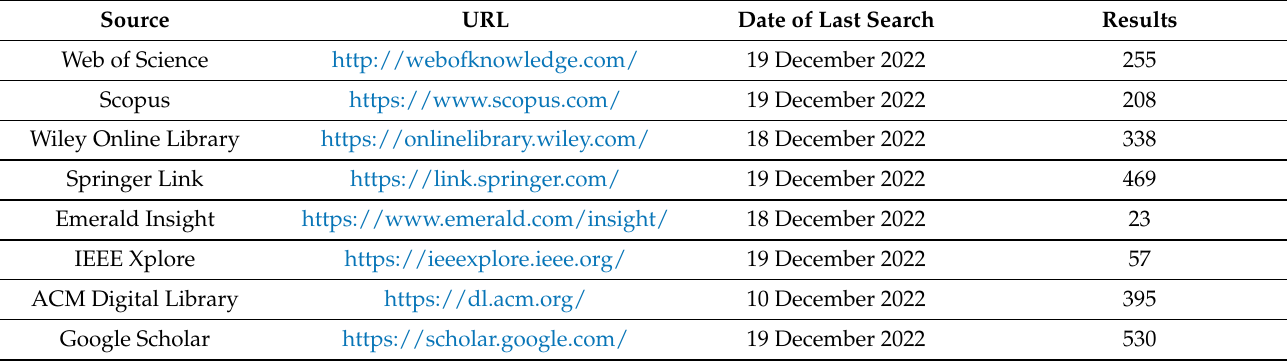
Table 2. Electronic databases and digital libraries searched for the literature review